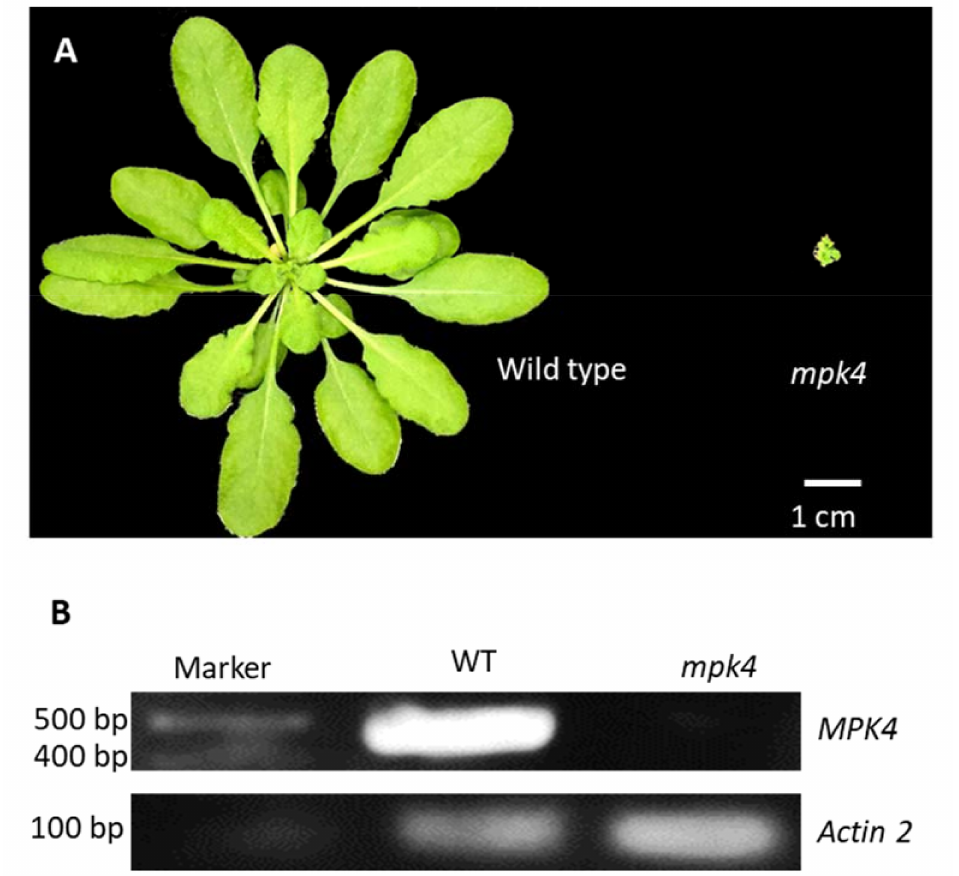
Figure 1. Morphological phenotype and transcript analysis of mpk4 . ( A ) 5-week-old Arabidopsis thaliana wild-type (WT) (left) and mpk4 mutant (right). ( B ) Semi-qPCR result showing abundant MPK4 transcript in WT, but none in the mpk4